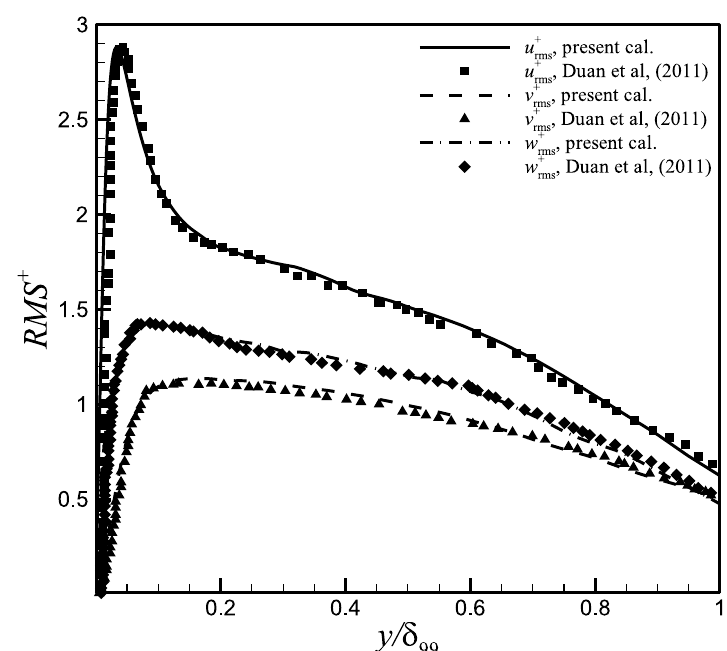
Fig. 5 Turbulence intensity versus Morkovin’s scaling at Re θ